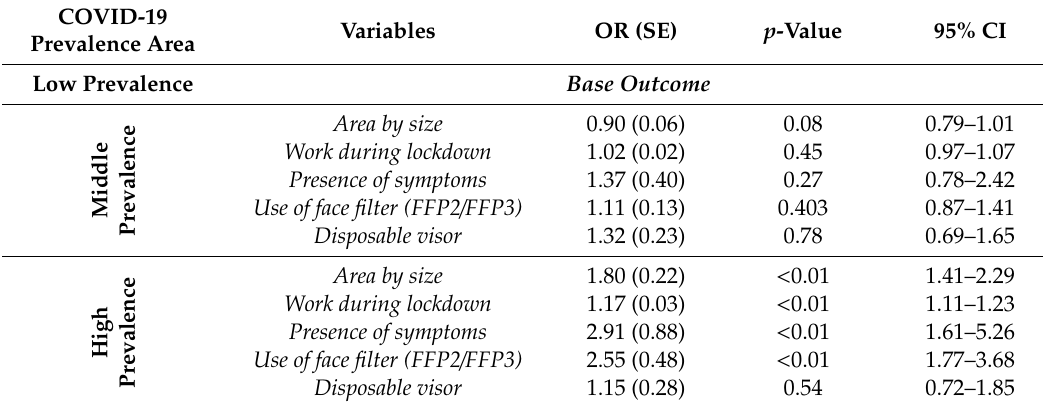
Table 6. Multilevel ordinal logistic regression about the COVID-19 prevalence area, the area by size, work during lockdown, state of health, use of face filter (FFP2 / FFP3) masks and disposable visor. The table includes the fixed-e ff ect portion of our model, the estimated cut-points and the estimated variance